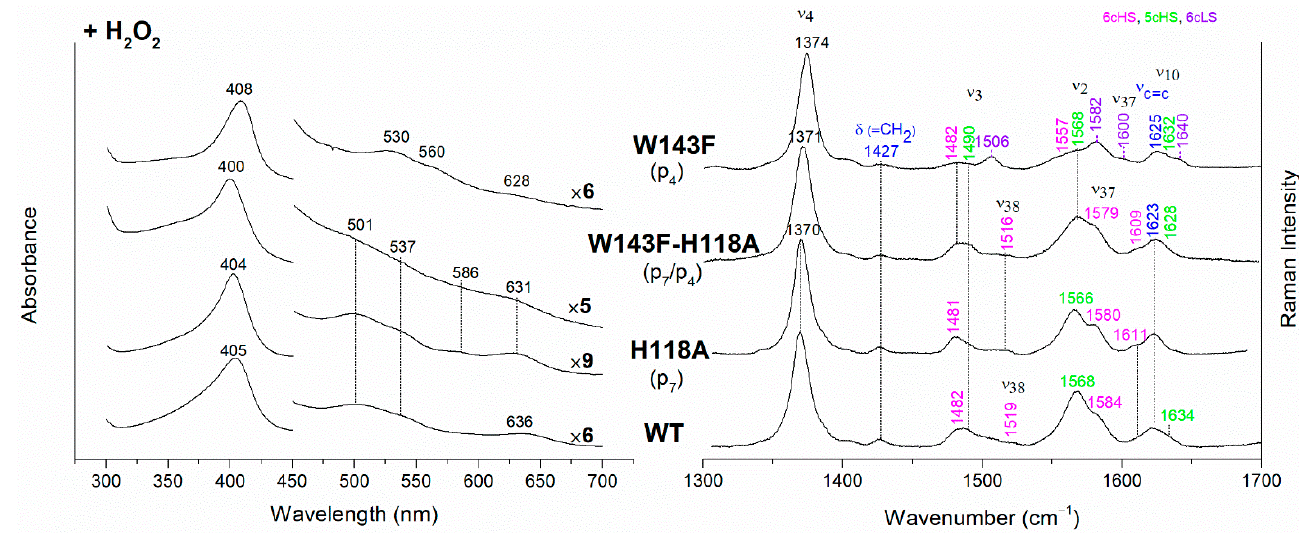
Figure 6. ( Left ) UV-vis electronic absorption spectra and ( Right ) RR spectra in the high wavenumber region of coproheme complexes upon H 2 O 2 titration of Cd ChdC WT and H118A, W143F and H118A-W143F variants. In brackets, the propionate, whose corresponding H-bond is removed by mutation, is reported. The RR core-size marker band wavenumbers are reported in pink, green and violet for the 6cHS, 5cHS and 6cLS species, respectively, while in blue are indicated the vinyl vibrations ( ν C=C stretching modes and δ (=CH 2 ) bending modes), and in black, at the side of the UV-vis spectra, are indicated the expansion factors applied in the 450–700 nm spectral range for better data visualization.